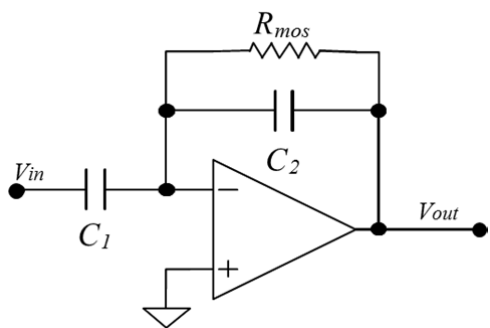
Figure 2. Readout circuit for recording the neuronal